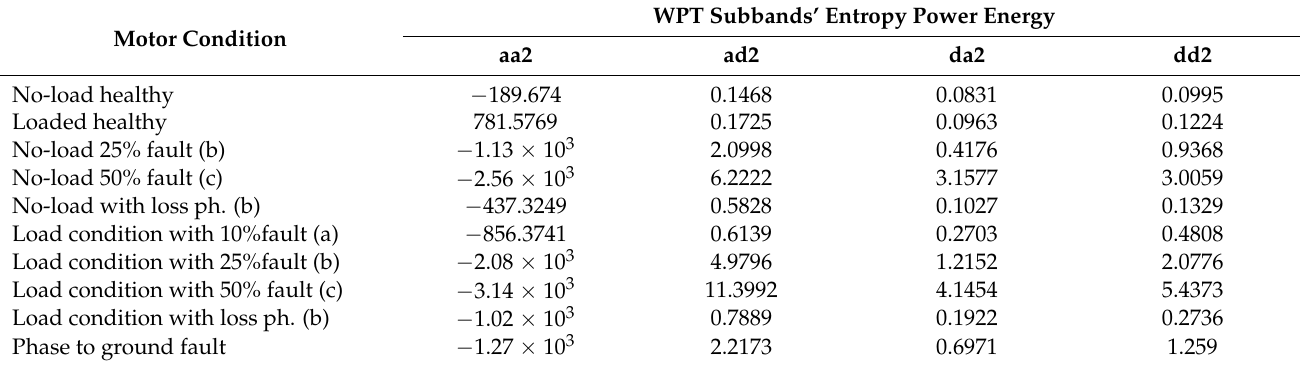
Table 5. Entropy power energy values of all four second level WPT subbands’ coefficients for different practical conditions of the induction motor.